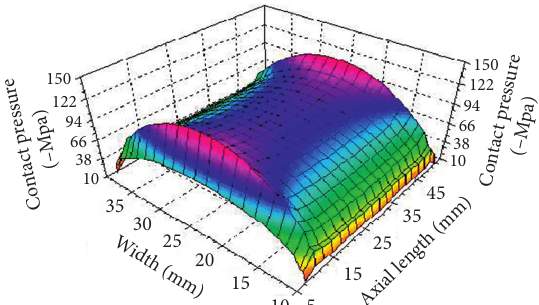
Figure 5: Pressure distributions in the contact area.